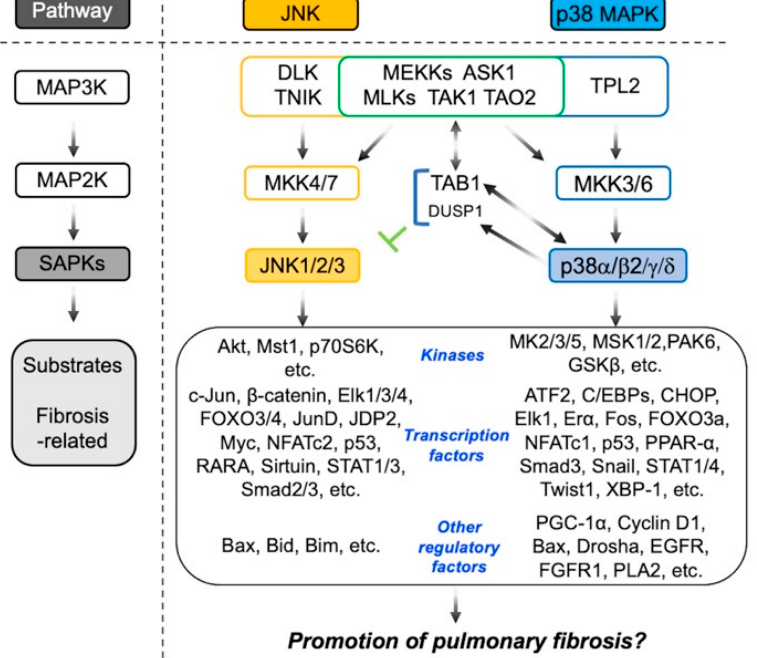
Figure 1. Schematic simplified representation of the JNK and p38 MAPK pathways in mammals. Both signaling pathways can be induced by inflammatory cytokines and profibrotic growth factors through an upstream activator sequence: MAP3K, MAP2K, and MAPK, promoting various regulatory proteins (kinases, transcription factors, transcriptional coregulators, post-transcriptional factors, and apoptosis-related factors) that are involved in the inflammatory and fibrotic responses. Lung fibrosis is recognized as an end-stage pathological development of the existing lung diseases caused by chronic inflammation, infection, autoimmunity, and idiopathy. Progressive pulmonary fibrosis has received considerable attention in recent years, because it causes respiratory failure and an increased risk of death. Most patients with IPF and some patients with nonspecific interstitial pneumonia develop a progressive fibrosing phenotype. In addition, interstitial pneumonia related with collagen tissue disease and chronic hypersensitivity pneumonia exhibit similar clinical course and pathological find- ings, although they are triggered by an exaggerated immune response and persistent exposure of an inhaled antigen. Various combinations of repeated alveolar, or